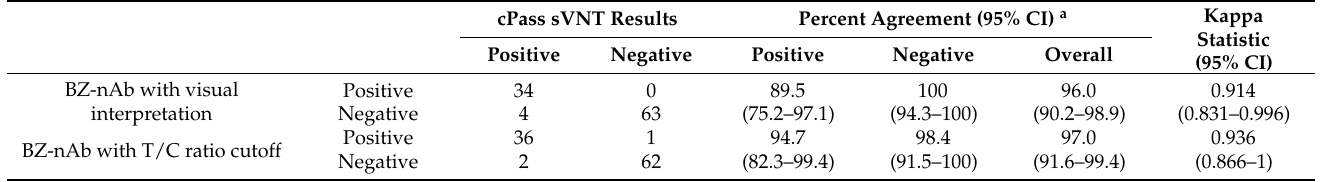
Table 2. Agreement between BZ COVID-19 neutralizing antibody test and cPass surrogate viral neutralization assay.